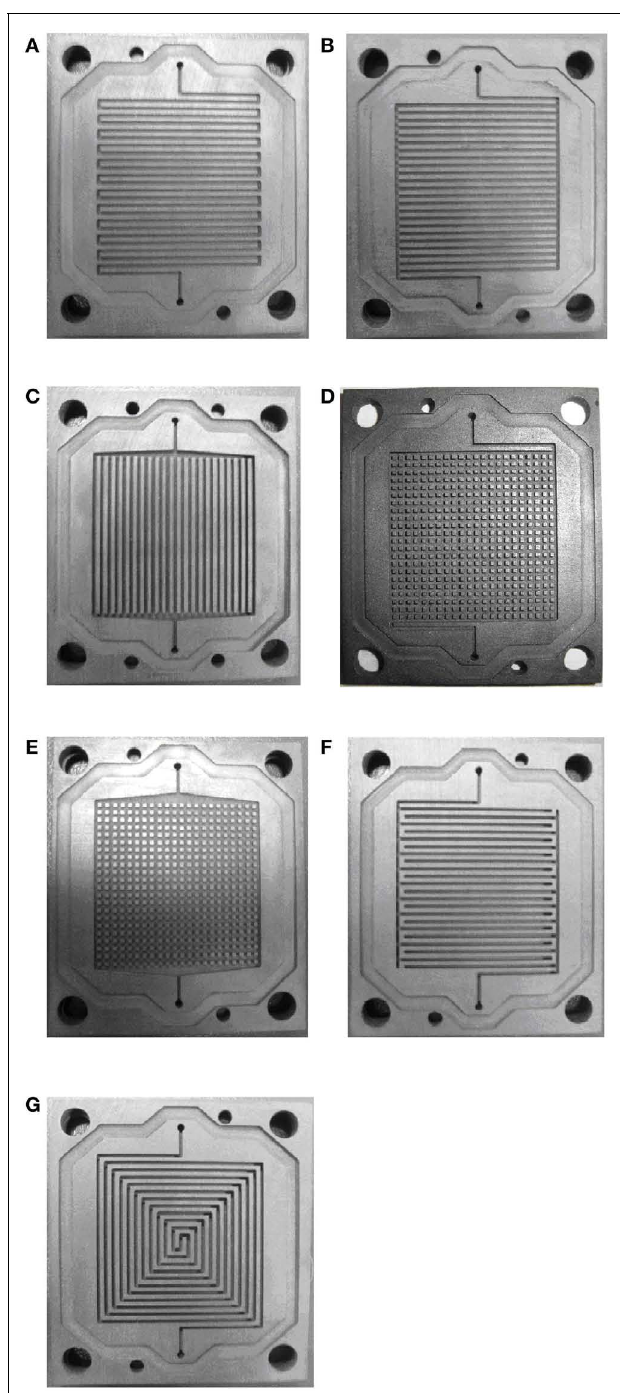
FIGURE 2 | Photographs of graphite plates with gas flow channels for PEM fuel cells in the experimental tests . (A) Serpentine, (B) ParallelV1, (C) ParallelV2, (D) PinV1, (E) PinV2, (F) Interdigitated, and (G)